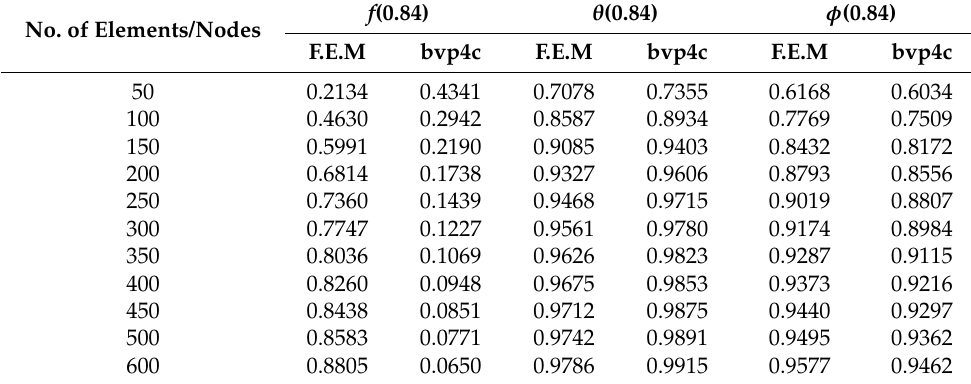
Table 1. Meshfree analysis for f , θ and φ with varying amounts of elements using = 0.9, P r =